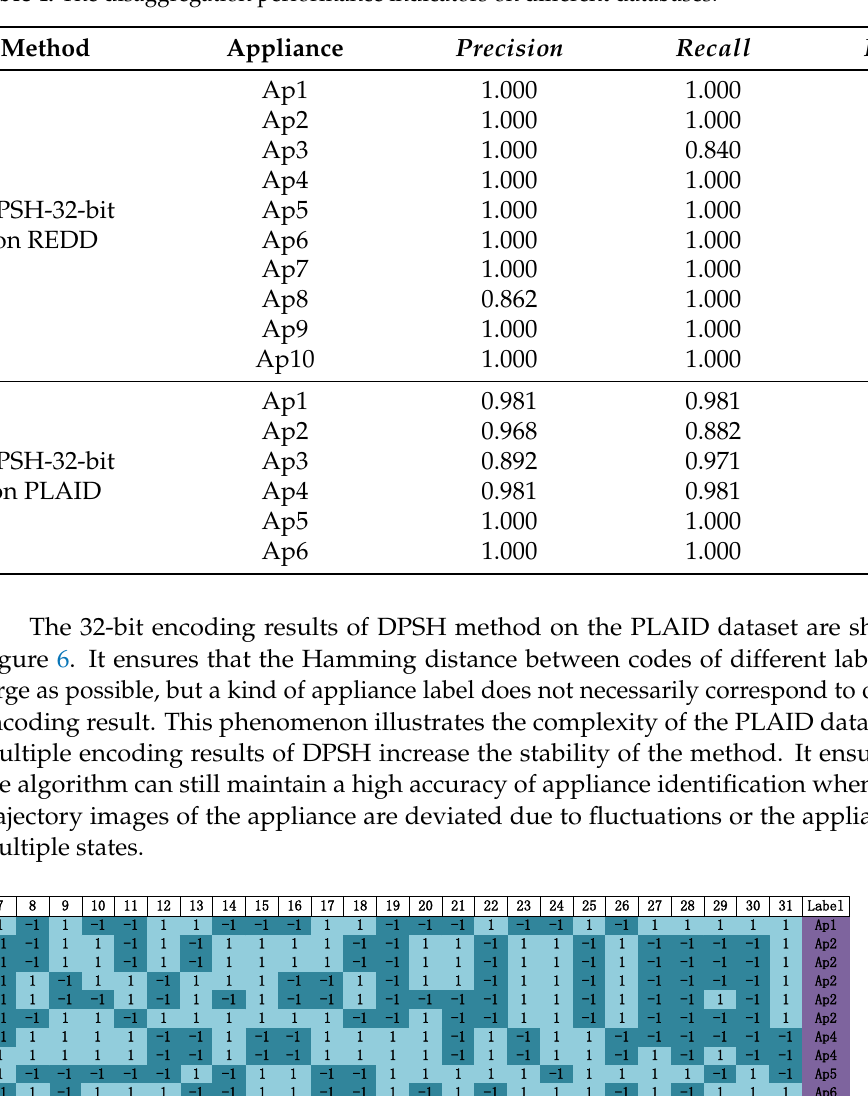
Table 4. The disaggregation performance indicators on different databases.